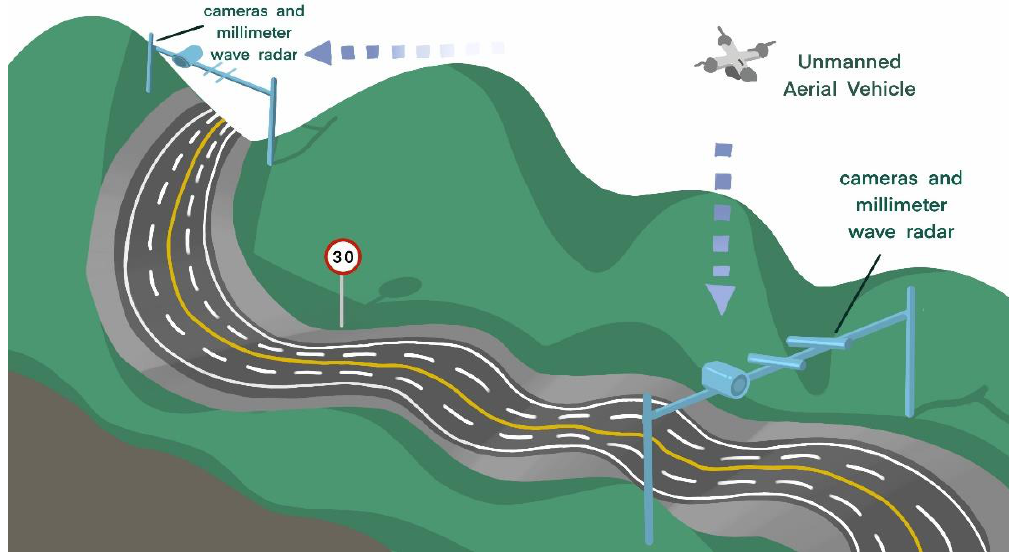
Figure 8. Use traffic sensors to collect changes in traffic parameters.